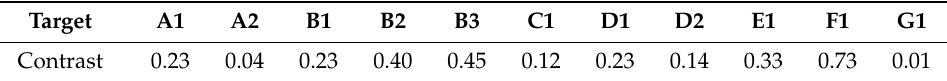
Table 1. Contrasts of infrared Maritime Targets in Figure